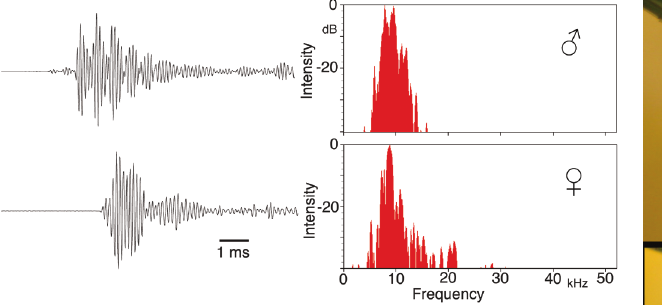
Fig. 7. Oscillograms of: A. A male syllable and; B. A female re- sponse together with power spectra (Hanning window, 512 points, mean of 12-ms-section of the song). mating.In contrast, in Orophus cf . tessellatus , FISH revealed a paracentro- meric signal on the fourth pair of autosomes (Fig. 9D)